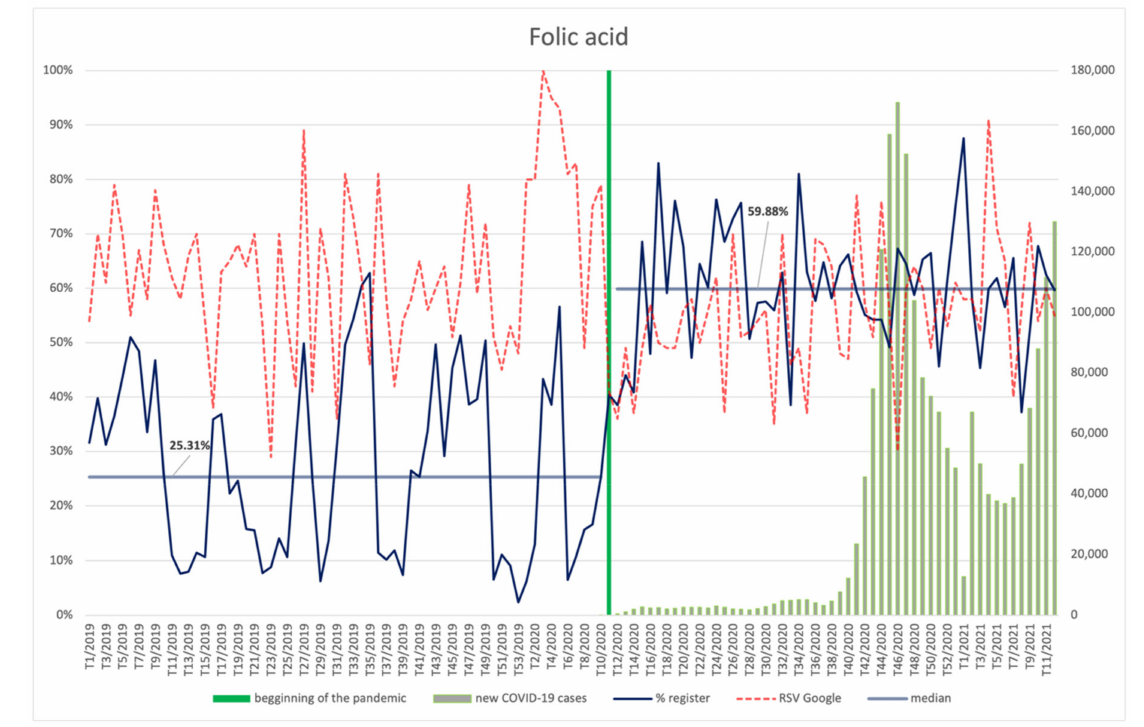
Figure 14. Comparison between the number of new registrations of products containing folic acid, the number of COVID-19 cases, and the frequency of search for information on the ingredient in the Google browser.